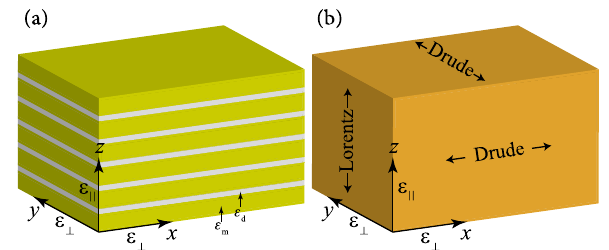
Figure 2. ( a ) Schematic of a multilayer metal-dielectric structure parallel to the xy -plane, as a typical 1D geometry of HMMs. ( b ) A multilayer HMM is an effective medium that has different dynamical properties in the direction parallel and perpendicular to its optical axis (the z -axis).